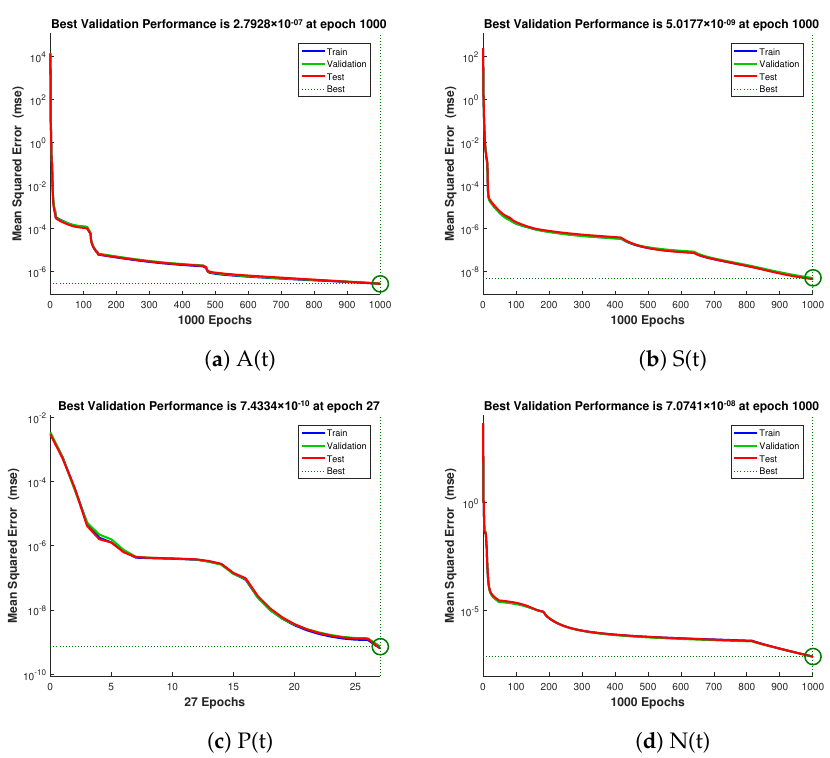
Figure 5. Mean square error of NNs-LMT for crop production, insects density, insecticides concentra- tion, and external effort of case 2.